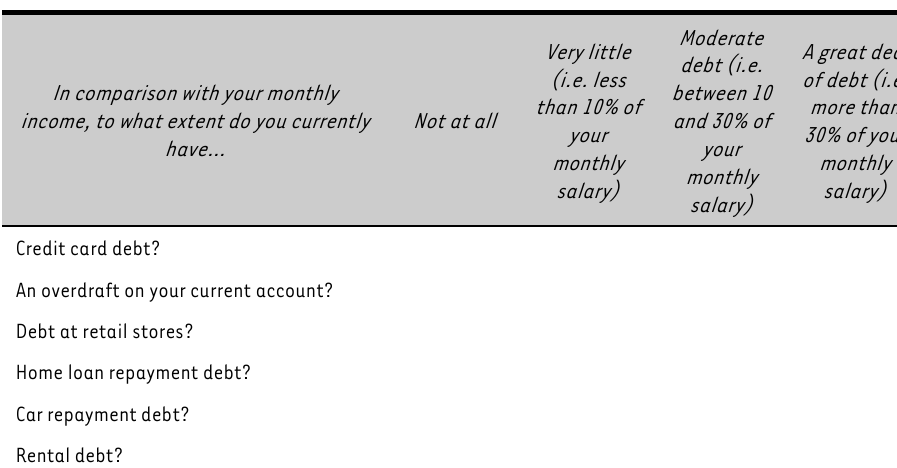
Questions related to